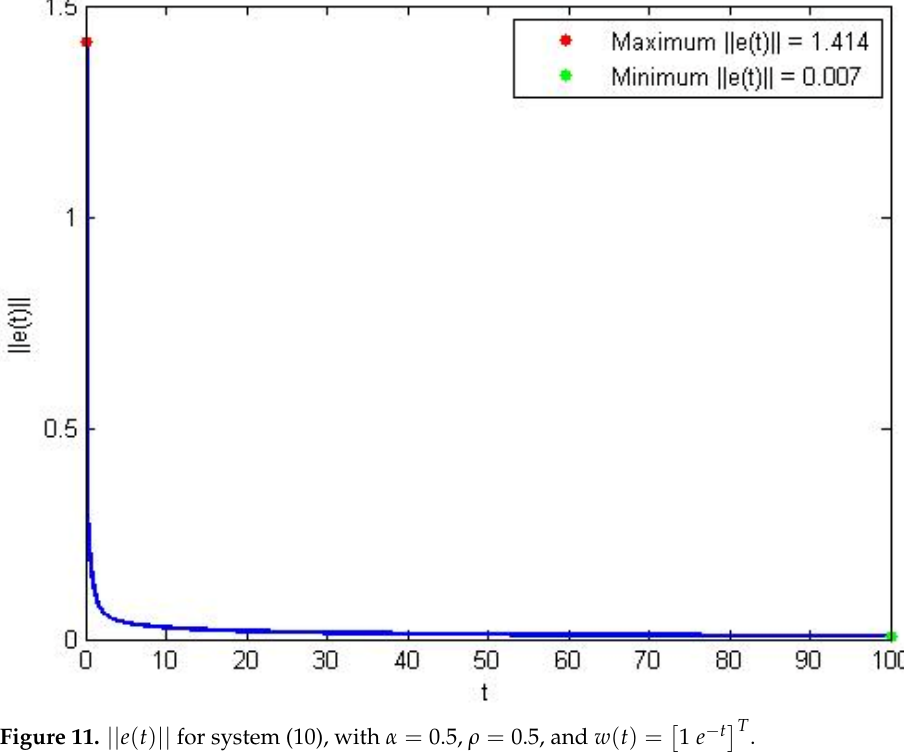
Figure 11. || e ( t ) || for system (10), with α = 0.5, ρ = 0.5, and w ( t ) = Figure 11. ‖𝑒(𝑡)‖ for system (10), with 𝛼 = 0.5 , 𝜌 = 0.5, and 𝑤(𝑡) = [1 𝑒 −𝑡 ] 𝑇 .